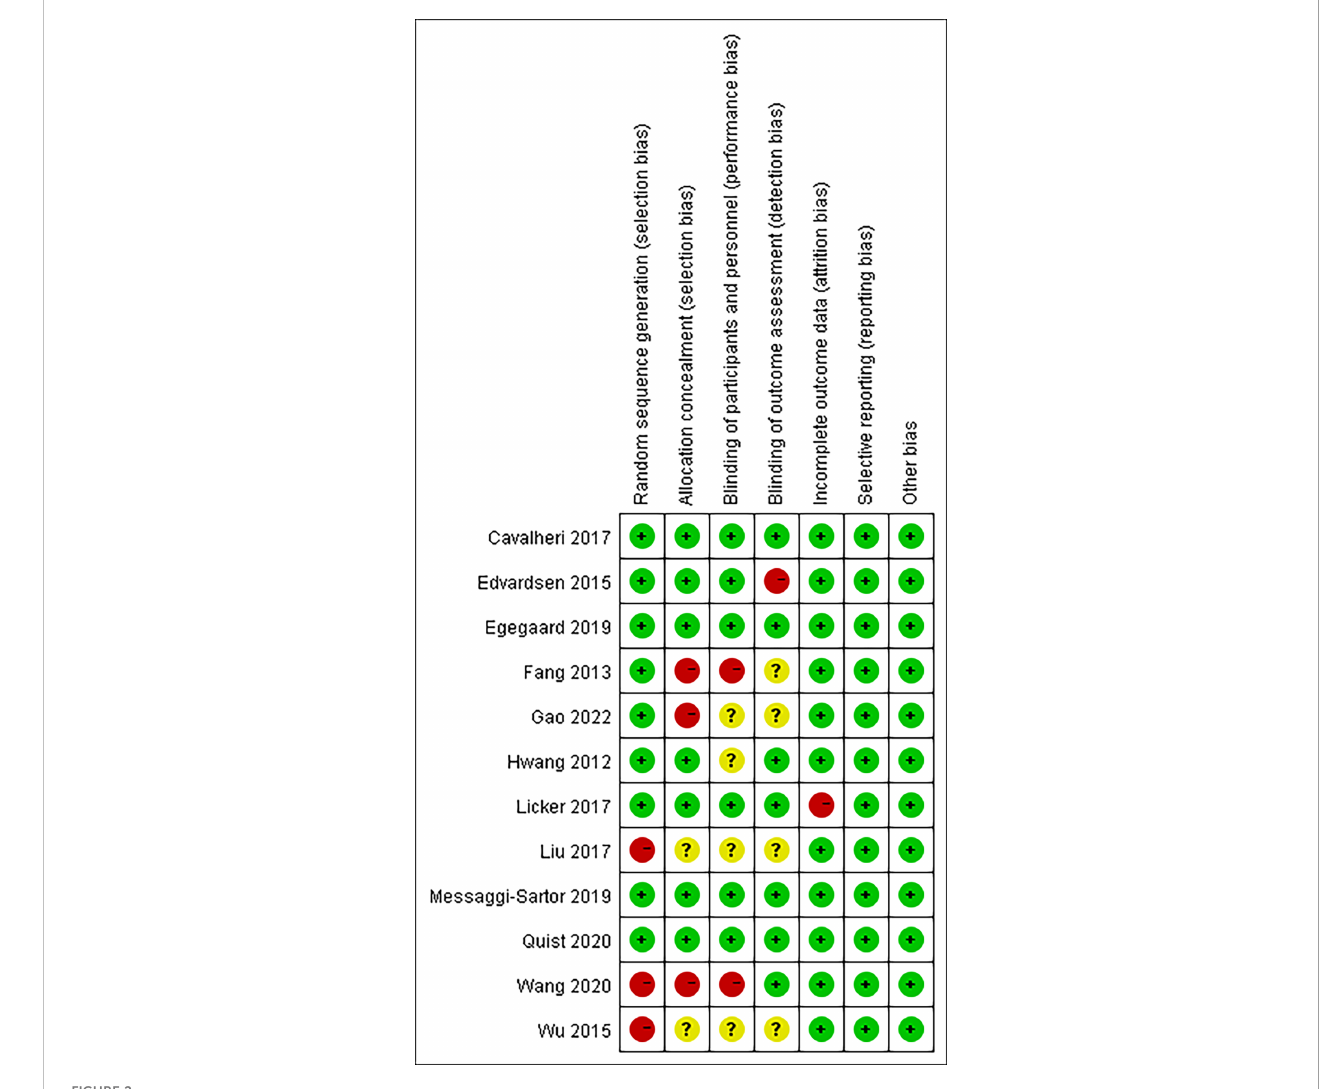
HIIT perioperatively were included (20 – 22). The results still support that HIIT bene fi ts FEV1 among patients with lung cancer compared with usual care (MD = 0.14; 95% CI = 0.08 to 0.20; I 2 = 36%; P < 0.0001) (Figure 4).